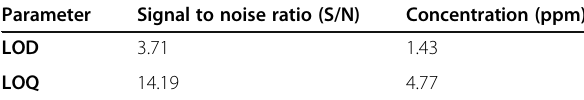
Table 6 LOD and LOQ results of the phenyl vinyl